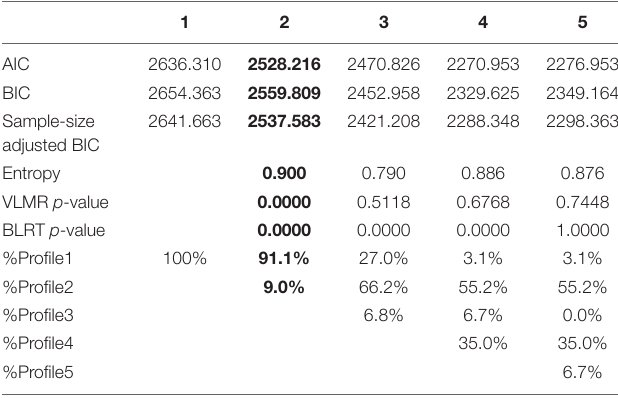
TABLE 4 | Latent profile analysis for Teacher’s play beliefs.